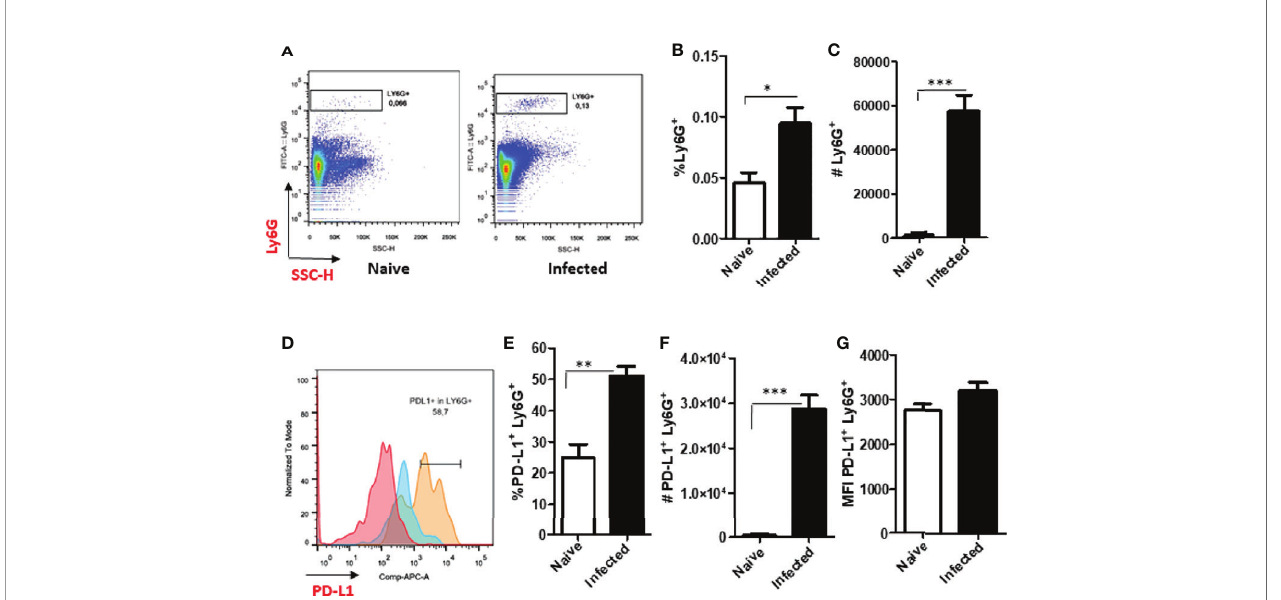
FIGURE 5 | Increased expression of Ly6G + and PD-L1 + in the draining lymph nodes of infected BALB/c mice. Mice were infected in the footpad with L. amazonensis promastigotes (2×10 6 ). After approximately 60 days, the draining lymph nodes were collected, macerated and the cells analyzed by fl ow cytometry. Controls were performed with uninfected mice (naïve). (A) Dot plot showing Ly6G + cells (Ly6G-FITC x SSC-H). (B) Percentage of Ly6G + cells. (C) Number of Ly6G + cells. (D) Histogram of PD-L1 (PD-L1-APC) expression. Red = Fluorescence minus one control (FMO) PD-L1; Blue = Naïve lymph nodes; Orange = Infected lymph nodes. (E) Percentage of PD-L1 + Ly6G + cells. (F) Number of PD-L1 + Ly6G + cells. (G) MFI of PD-L1 + Ly6G + . Data are mean ± SEM of individual mice (5 mice/group) shown as a representative experiment of three producing the same result pro fi le. *p < 0.01, **p < 0.001, ***p <